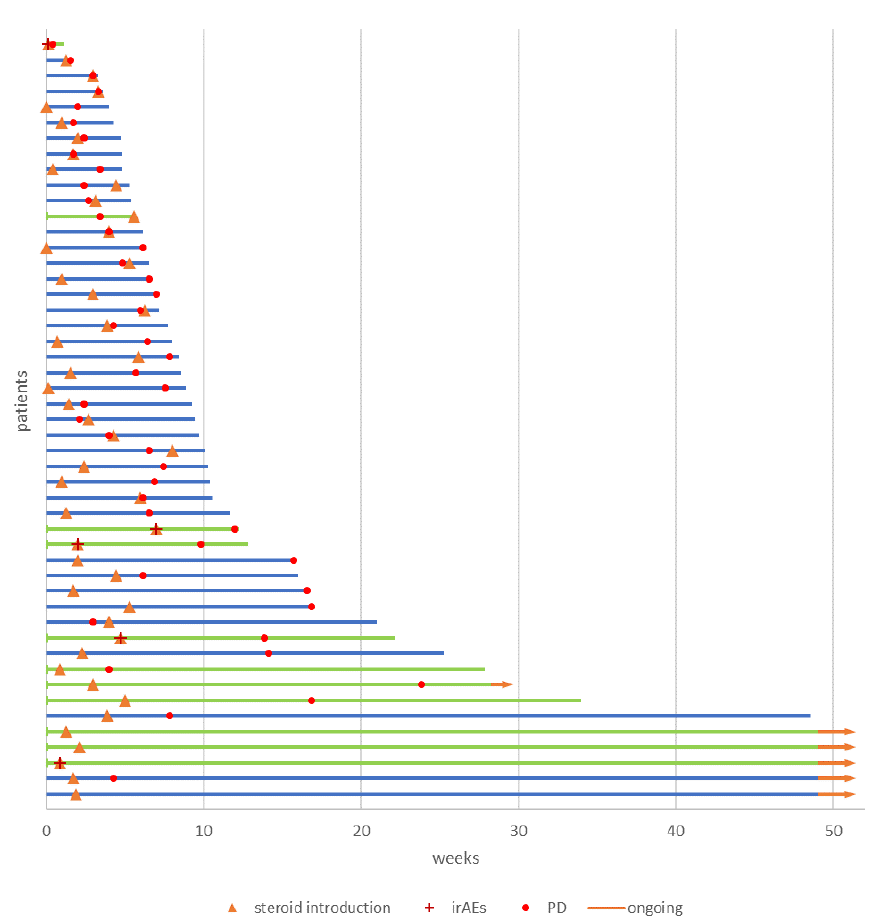
Figure 2. Swimmers plot detailing progression survival (PFS) and overall survival (OS) after one year of follow-up of patients receiving intercurrent steroids for cancer-related (blue) and not related (green) indications. Abbreviations: Immune-related adverse events (irAEs); progressive disease (PD). Intercurrent steroids for cancer-related symptoms was an independent factor for PFS [HR 2.64; 95% CI, 1.24 to 5.61; p < 0.0001] and OS [HR 4.53; 95%CI, 1.8 to 11.1); p < 0.0001] in the multivariate analysis, including age, gender, smoking status, histology, ECOG PS, and antibiotics at baseline (Table 2). The ECOG PS ≥ 2 and a precedent/concomitant use of antibiotics were independently associated with poor PFS (respectively HR 1.5, (95% CI, 1.1 to 2.2) p = 0.01, and 1.3, (95% CI,1 to 1.8), p = 0.01) and OS (respectively HR 2.1, (95% CI 1.4 to 3.1), p < 0.0001, and 1.6, (95% CI, 1.1 to 2.1) p = 0.003) (Table 2 and Table S3).